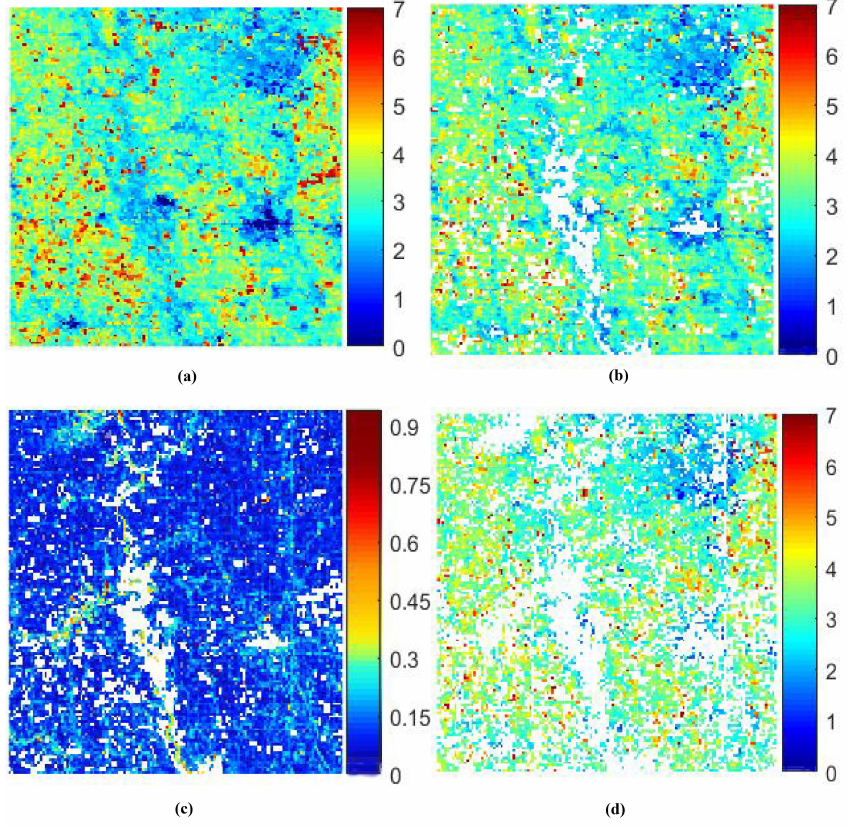
Figure 3. The MODIS leaf area index (LAI) pixel filtering process. From left to right: ( a ) original MODIS LAI; ( b ) MODIS LAI pixels for cropland with the highest retrieval quality (main algorithm and not saturated); ( c ) CV map of NIR band4 from Landsat5; and ( d ) final selected homogeneous and pure MODIS LAI